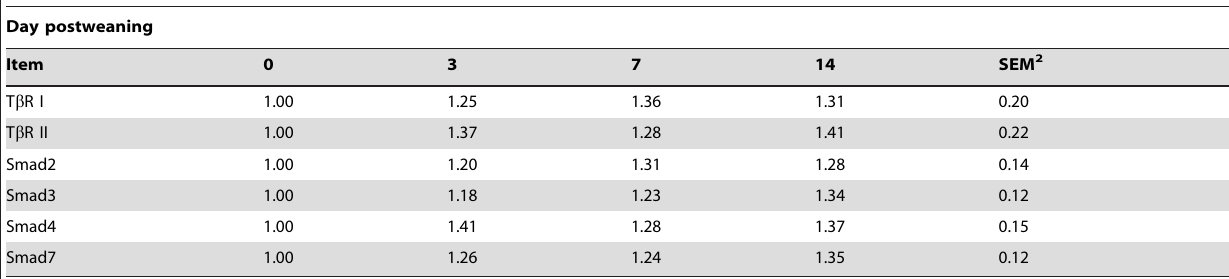
Table 4. mRNA expressions of smads signals in weanling pigs. 1